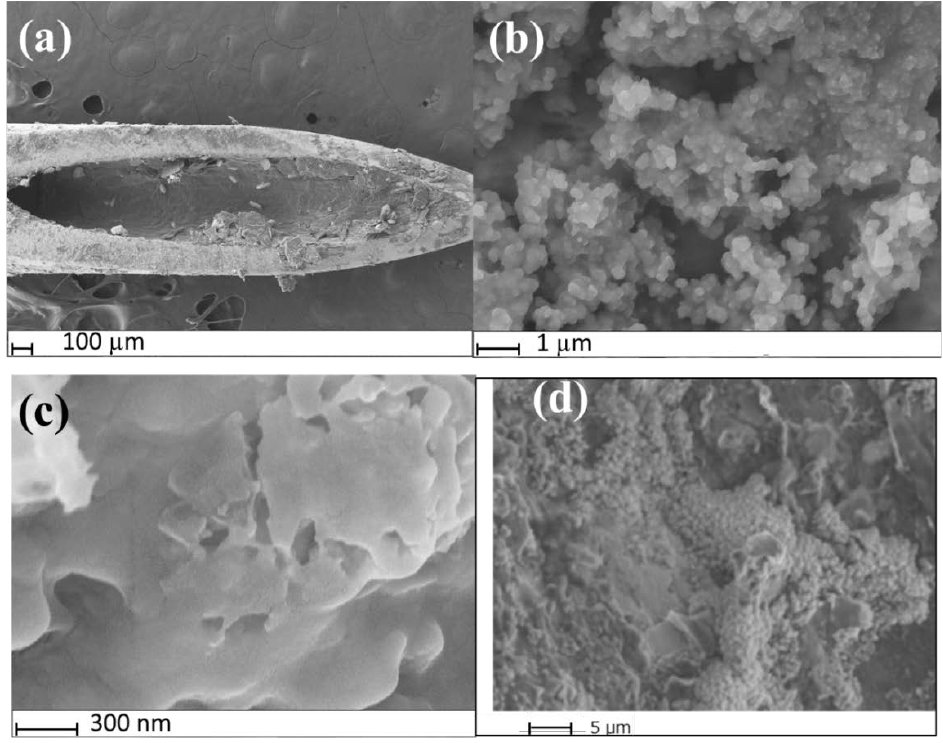
Figure 2. SEM images of ( a ) MIP@CNT/CNC MN sensor tip; ( b ) surface of MIP@CNT/CNC MN sensor at high magnification; ( c ) surface of the NIP@CNT/CNC at high magnification; ( d ) morphology of the surface of MIP@CNT/CNC MN sensor after repeated